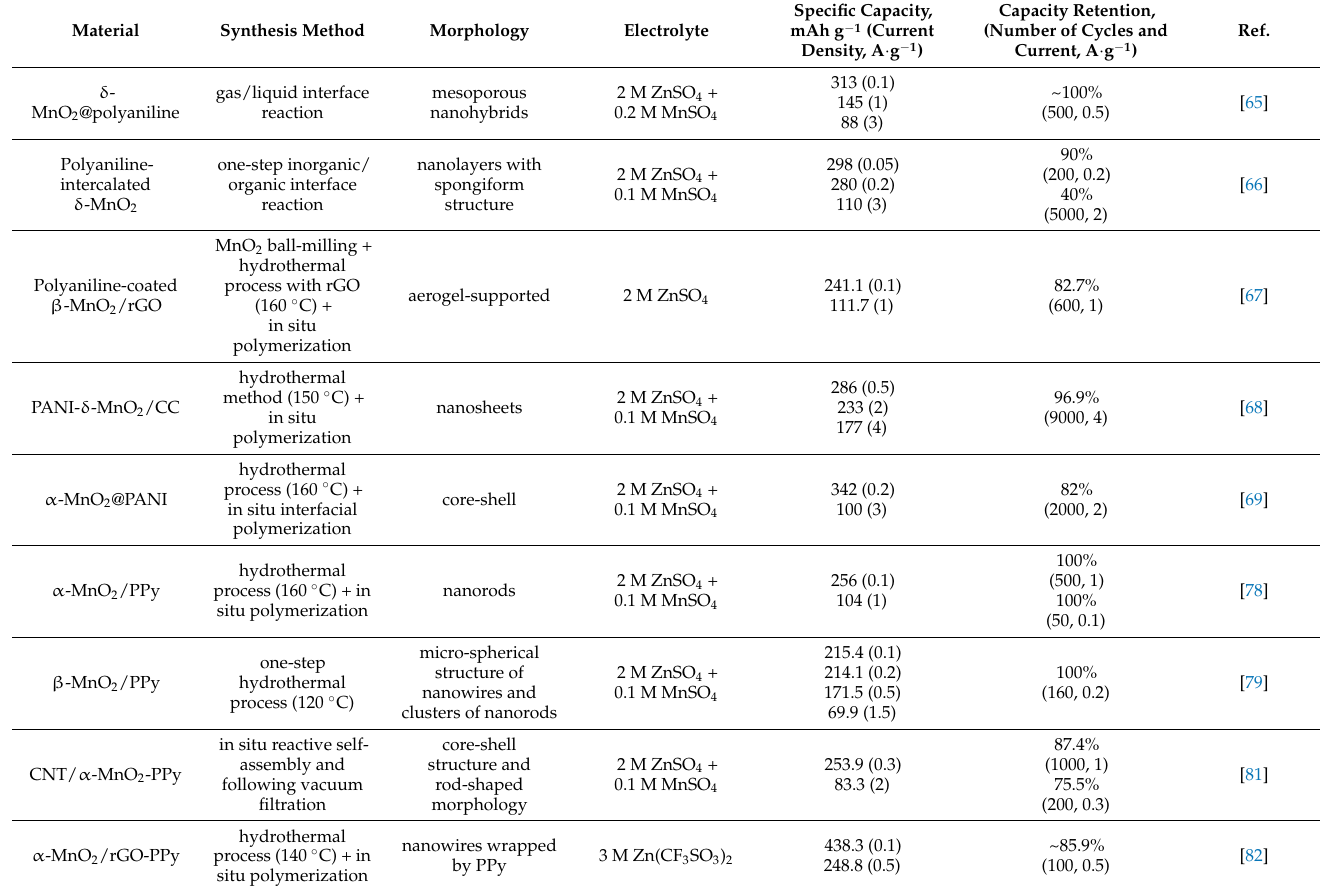
Table 2. Electrochemical performance of selected MnO 2 -based composites with conducting polymers as cathodes in